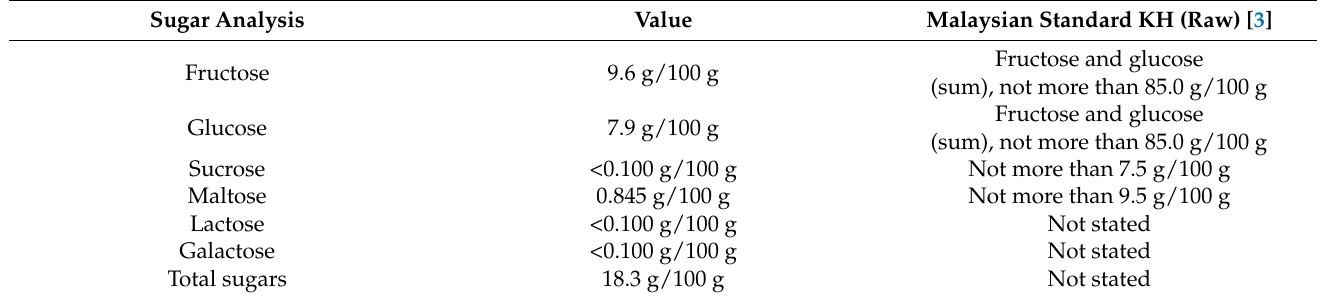
Table 4. Comparison of sugar contents in KH and Malaysian Standard KH